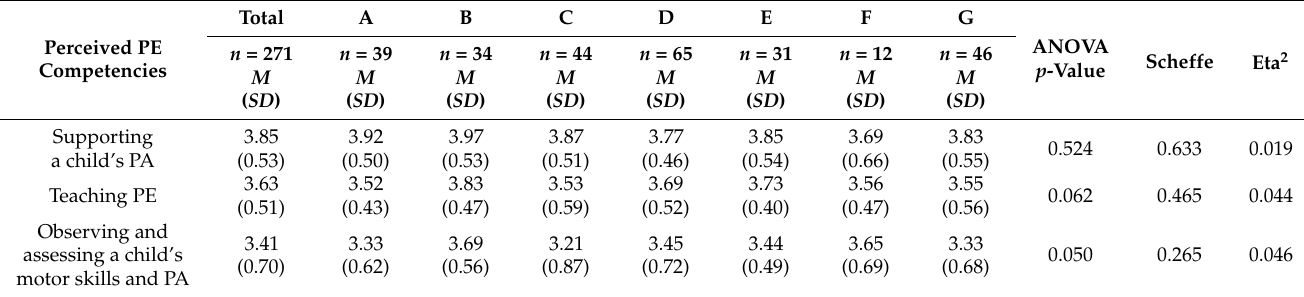
Table 2. A comparison of pre-service teachers’ perceived PE competence in different Finnish universities.